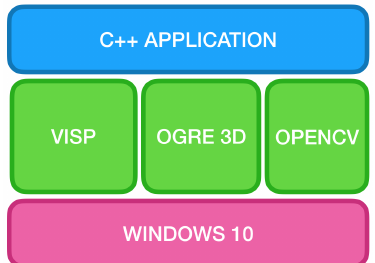
Figure 3. Software layers of the proposed system. ViSP (Visual Servoing Platform), OpenCV